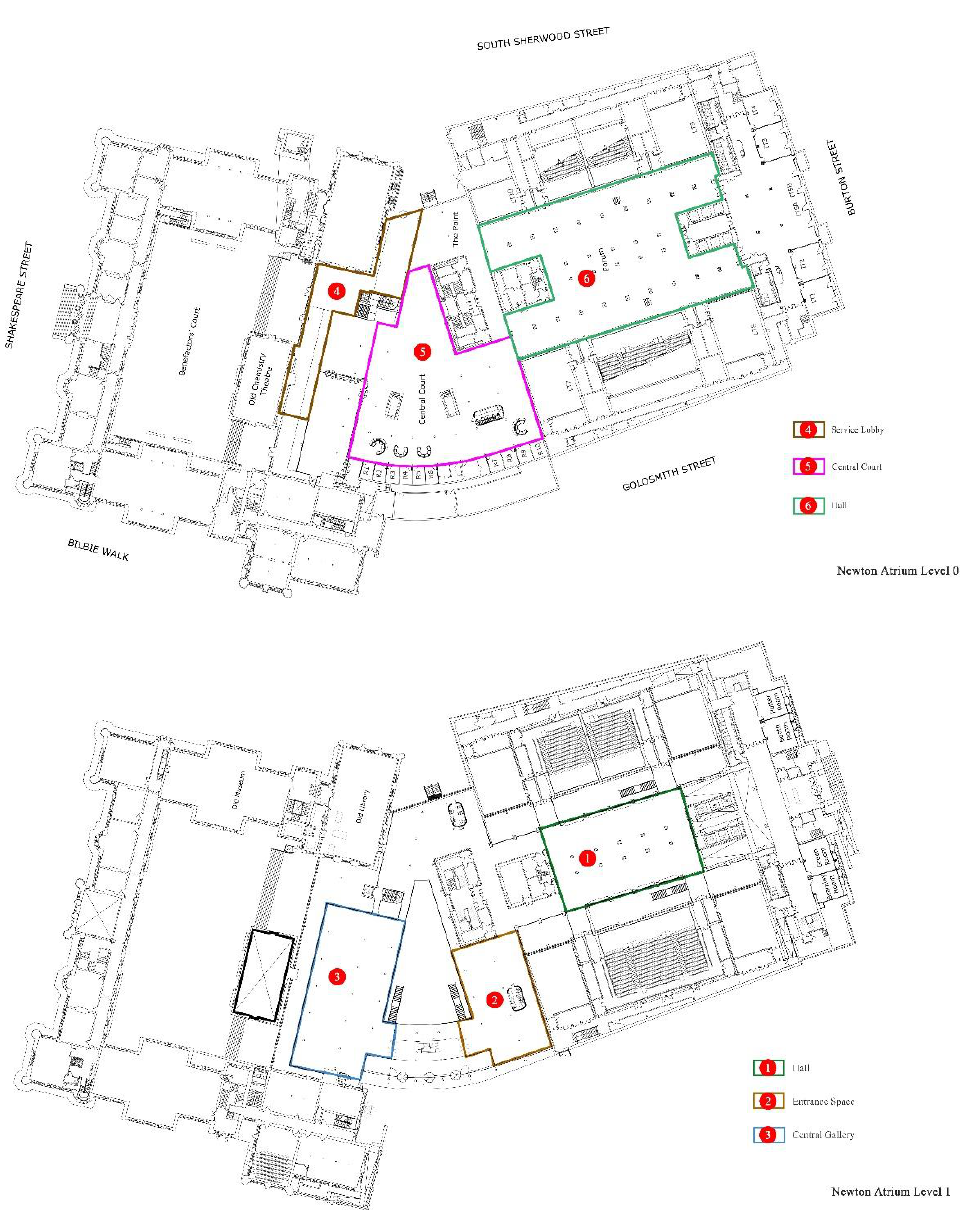
Figure 5. Floor plan of Newton with different functional zones (Level 0 and Level 1).